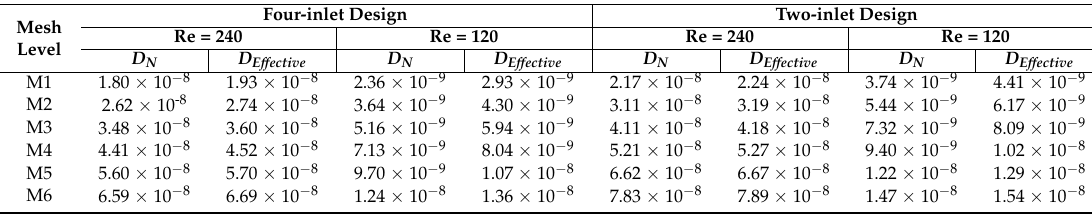
Table 3. Computed numerical ( D N , m 2 /s) and effective ( D Effective , m 2 /s) diffusion constants for different micromixer designs, flow scenarios, and mesh densities.